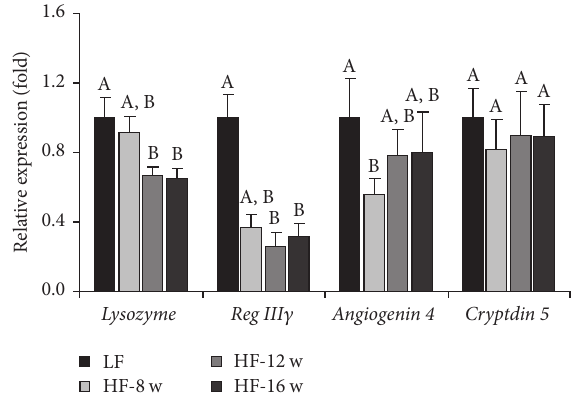
Figure 3: Effect of HF consumption on the relative expression of Paneth cell-antimicrobial peptides. Except for cryptdin 5 , the mRNA expressions of lysozyme, Reg III 𝛾 , and angiogenin 4 were significantly reduced at either 8 weeks or 12 and 16 weeks of HF